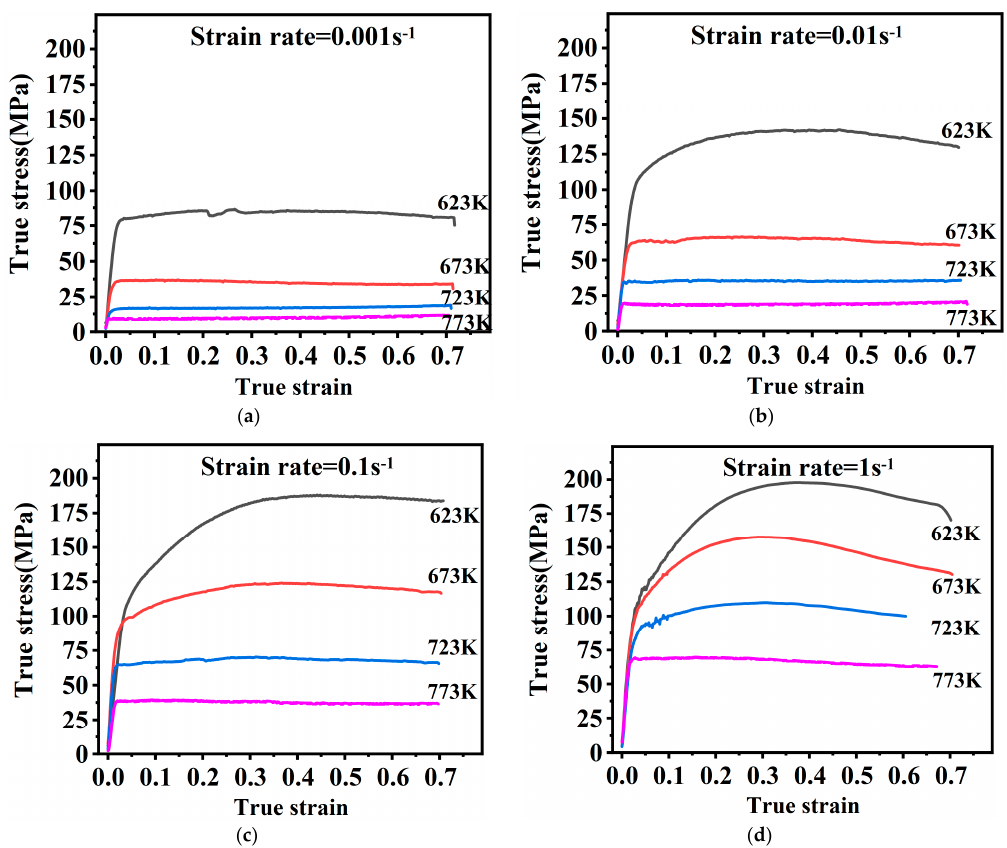
Figure 2. The fl ow stress curves under di ff erent test conditions. ( a ) 0.001s − 1 , ( b ) 0.01s − 1 , ( c ) 0.1s − 1 , ( d ) 1s − 1 . Figure 2. The flow stress curves under different test conditions. ( a ) 0.001s